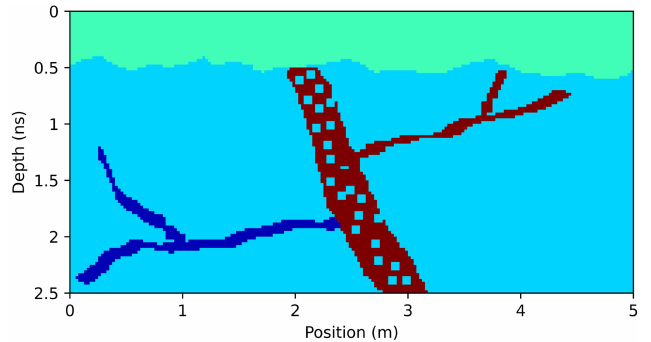
Figure 15. The model of the complex tunnel lining.